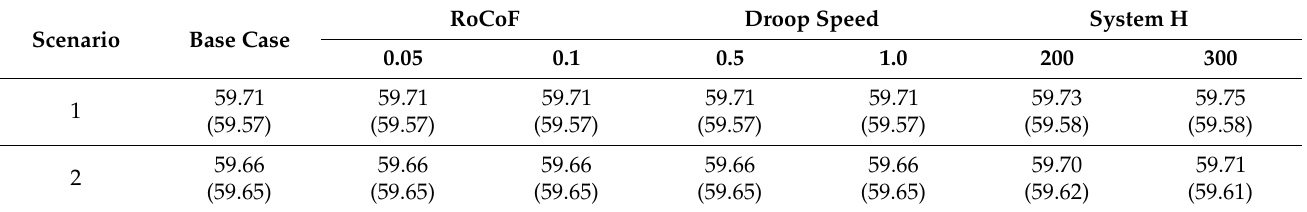
Table 11. Lowest frequency per parameter (RoCoF Control) (Hz): three-phase short circuit.